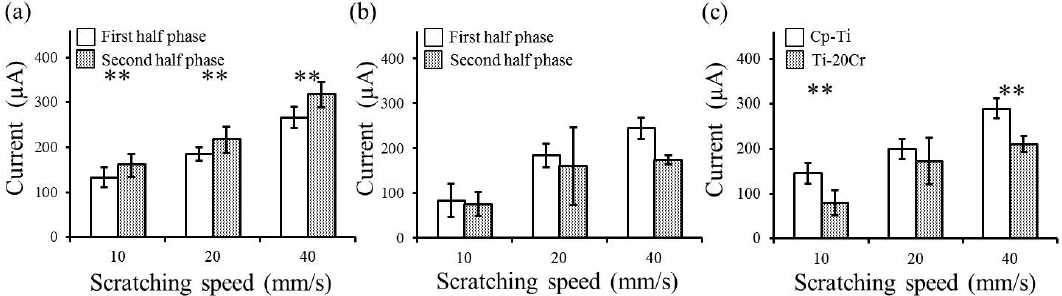
Figure 4. Average values of activation peaks in commercially pure titanium (CP-Ti) and titanium alloys containing 20 mass% chromium (Ti-20Cr) at different scratching speeds: ( a ) CP-Ti, ( b ) Ti-20Cr ( c ) Total phase (first + second half-phase). First and second half-phases indicate one to five and six to 10 scratching cycles, respectively. The asterisk indicates statistical significance of the difference between groups ( p < 0.01).